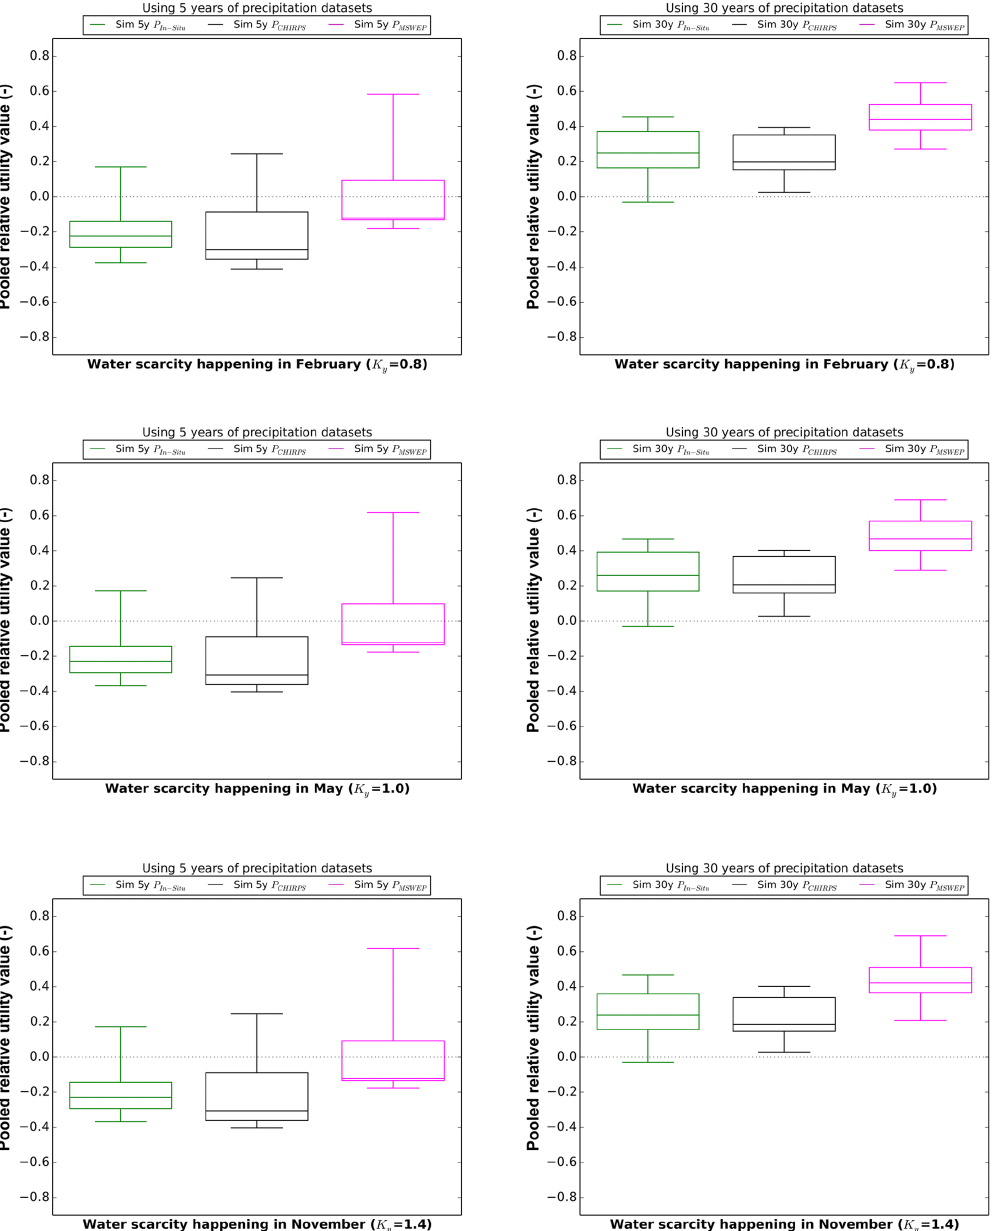
Figure 12. Pooled relative utility value using simulated river discharge of 5 and 30 years for water scarcity happening independently in February, May or November. K y is the sensitivity of the crop to water deficit. Boxplots show the median, interquartile range and minimum– maximum